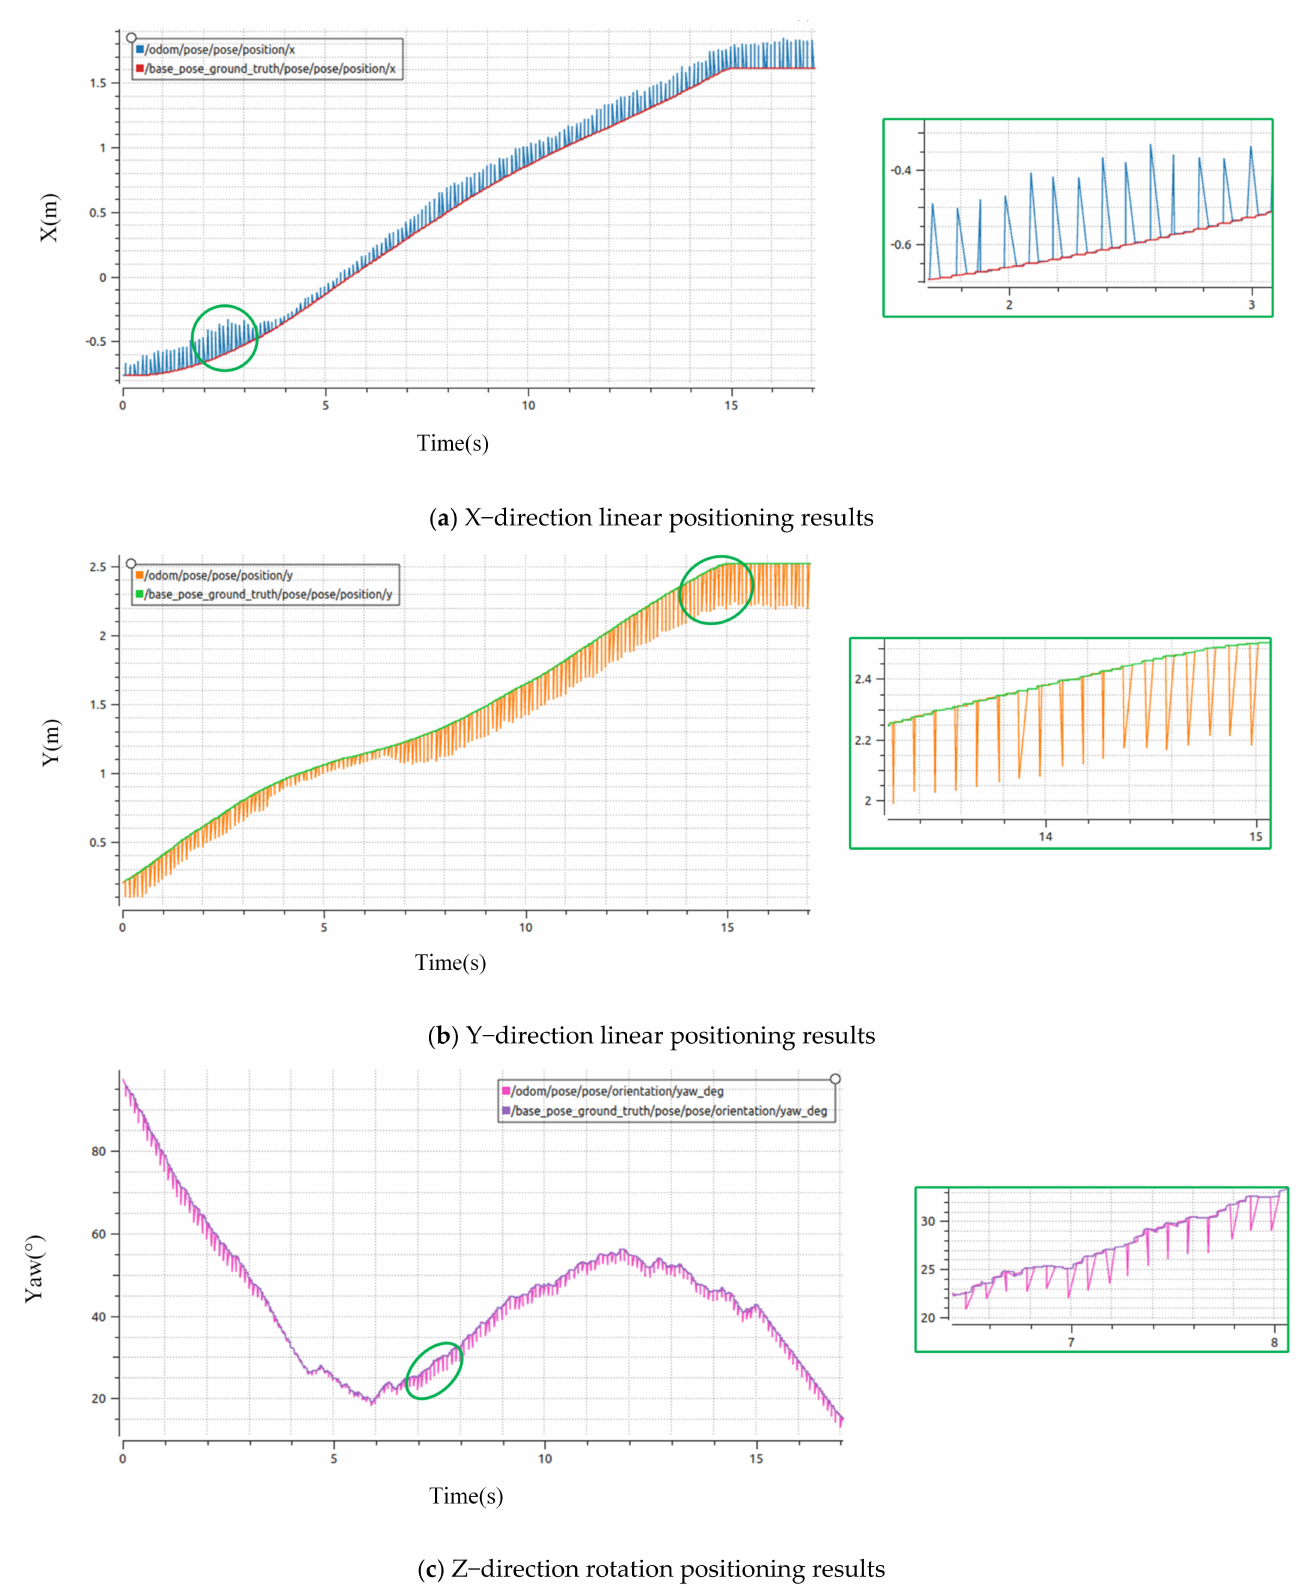
Figure 15. Results of the first group of hdl_localization simulation positioning